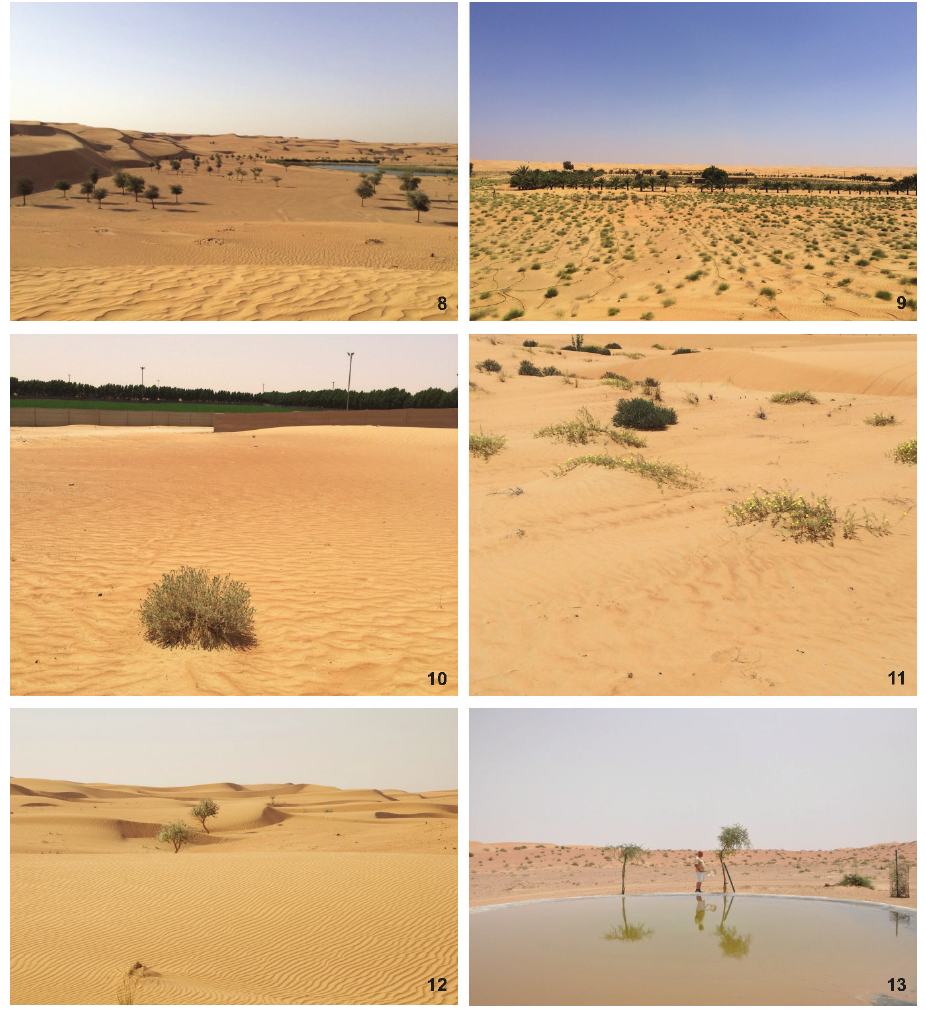
Polycarpaea repens (Caryophyllaceae) and Neurada procumbens (Neuradaceae). Only one plant each of Indigofera intricata , Crotalaria aegyptiaca and Citrullus colocynthis (Cucurbitaceae) were noted. Site 25. Sand dunes with scattered Calotropis procera trees (Figure 12) Site 26. Faqah watering point (Figure